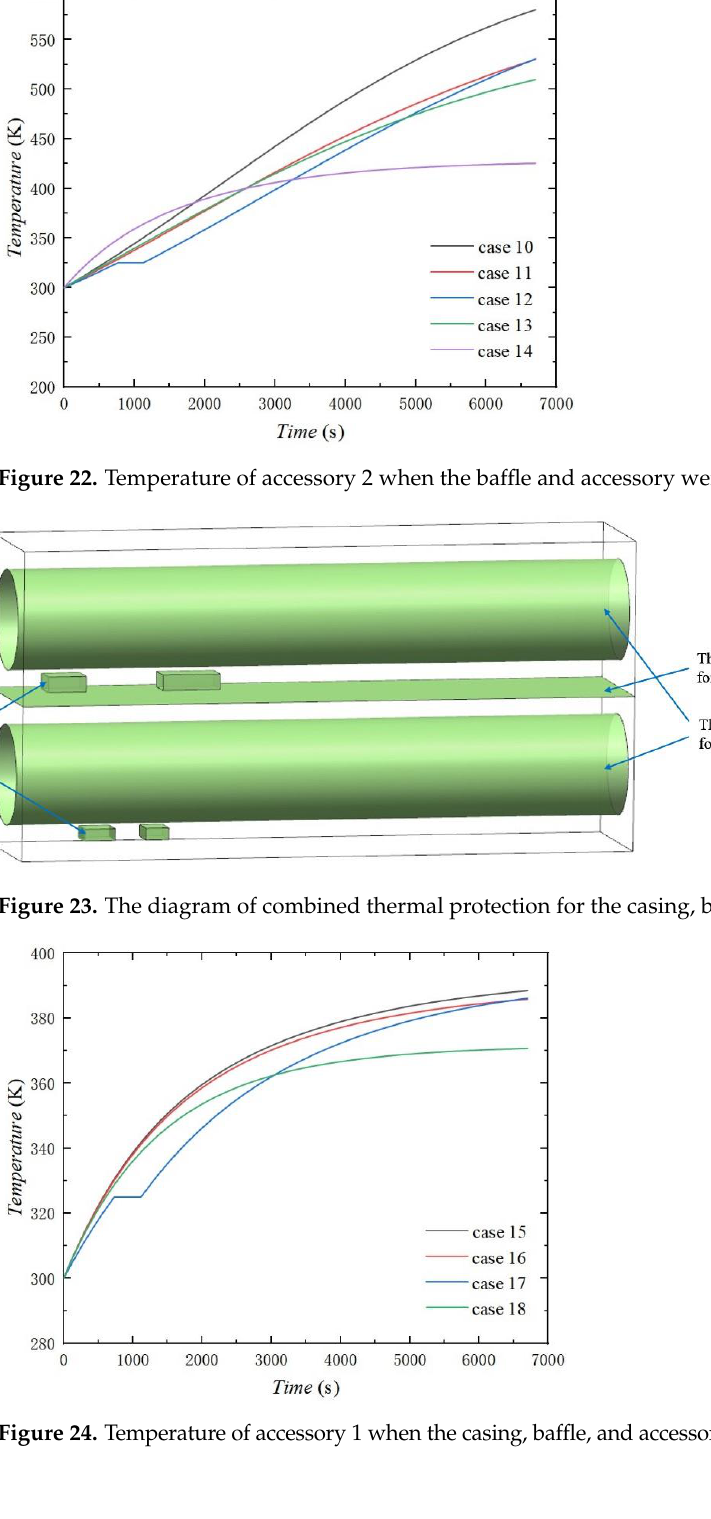
Figure 22. Temperature of accessory 2 when the baffle and accessory were thermally protected.